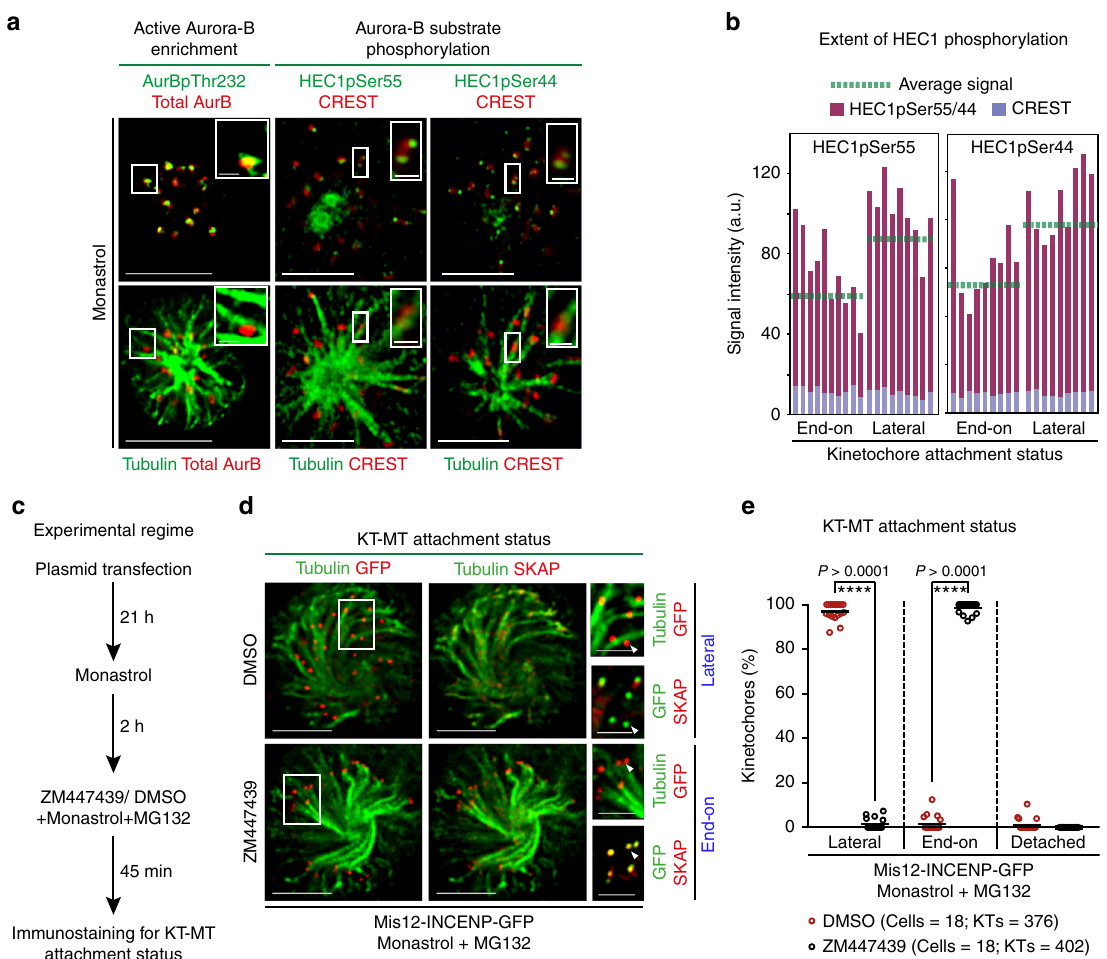
Fig. 1 High Aurora-B activity promotes KT attachment to MT-walls. a Representative images show high Aurora-B activity on lateral kinetochores. Monastrol treated cells were immunostained with antibodies against Tubulin, Aurora-BpThr232 and total Aurora-B (AurB) ( left panel ) or CREST antisera and antibodies against Tubulin and either HEC1pSer55 ( middle panel ) or HEC1pSer44 ( right panel ). Cropped images show lateral-kinetochores. Scale: 5 μ m in uncropped images; 1 μ m in cropped images. b Graphs show higher average signal intensities of HEC1pSer55 ( left ) and HEC1pSer44 ( right ) in lateral compared to end-on kinetochores as assessed from at least nine randomly chosen kinetochores from cells in a . CREST signal intensities are used as internal controls. c Experimental regime: Cells transfected with plasmid vectors encoding Mis12-INCENP-GFP were exposed to Monastrol and MG132 with either ZM447439 or DMSO (solvent control), prior to immunostaining. d Images of cells expressing Mis12-INCENP-GFP treated as in c and immunostained with antibodies against Tubulin, SKAP and GFP. White arrowheads in cropped images show ‘ Lateral ’ kinetochore lacking SKAP ( upper panel ) and ‘ End-on ’ kinetochore enriched with SKAP ( lower panel ). Scale: 5 μ m in uncropped and 2 μ m in cropped images. Boxed areas in a and d correspond to cropped images. e Graph shows percentage of lateral, end-on and detached kinetochores in Mis12-INCENP-GFP expressing cells treated as in c . Each circle represents value from one cell. Black horizontal bar marks average values from three independent experimental repeats. ‘ * ’ indicates statistically signi fi cant difference on the basis of P -values obtained using unpaired Student ’ s t